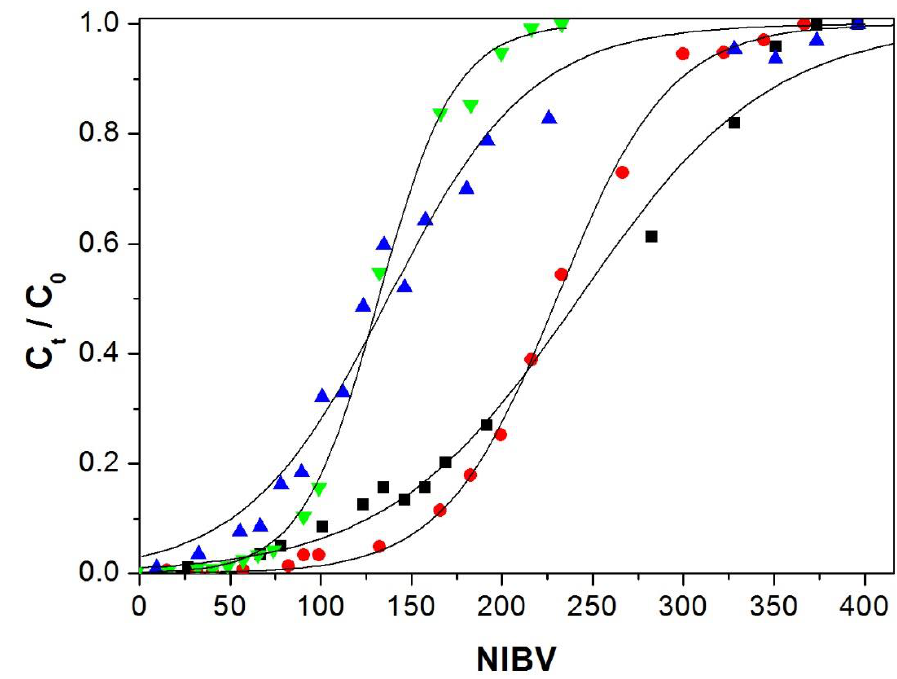
Figure 6. Breakthrough curves for Cu(II) adsorption, column height 13 cm and Cu(II) concentration 50 mg/L. Experimental Alg-ChS hydrogel: flow rate ● 50 mL/h, ■ 100 mL/h. Experimental Alg-Ch: flow rate ▼ 50 mL/h, ▲ 100 mL/h. Thomas model predictions (—).